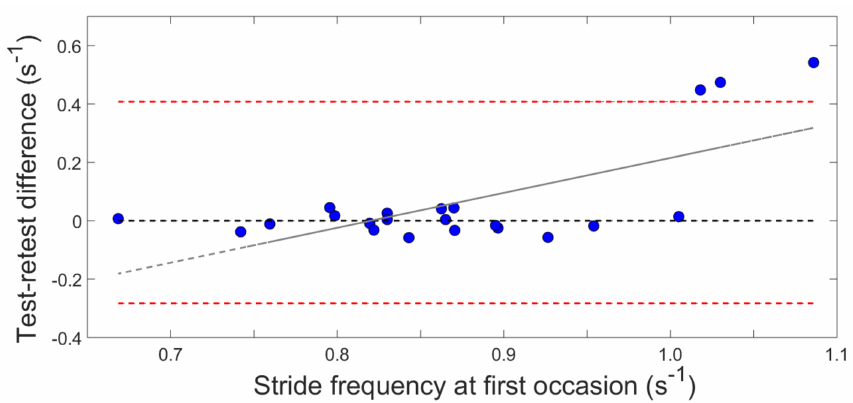
Figure 5. Bland–Altman plot of the stride frequency during gait at a fast speed. The differences in the stride frequency between the test-retest measurements in relation to the stride frequency during the first test session are shown for all 22